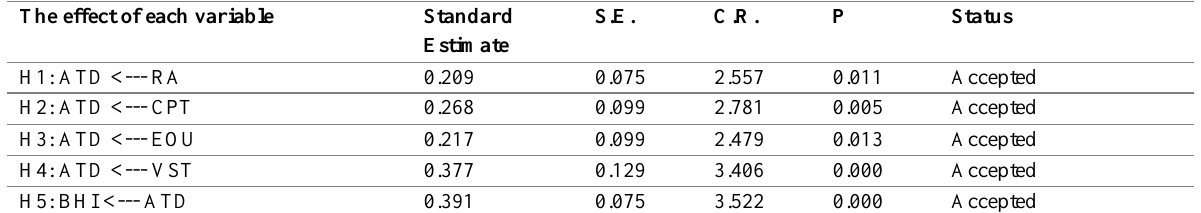
Table 3: Hypotheses Testing: Direct